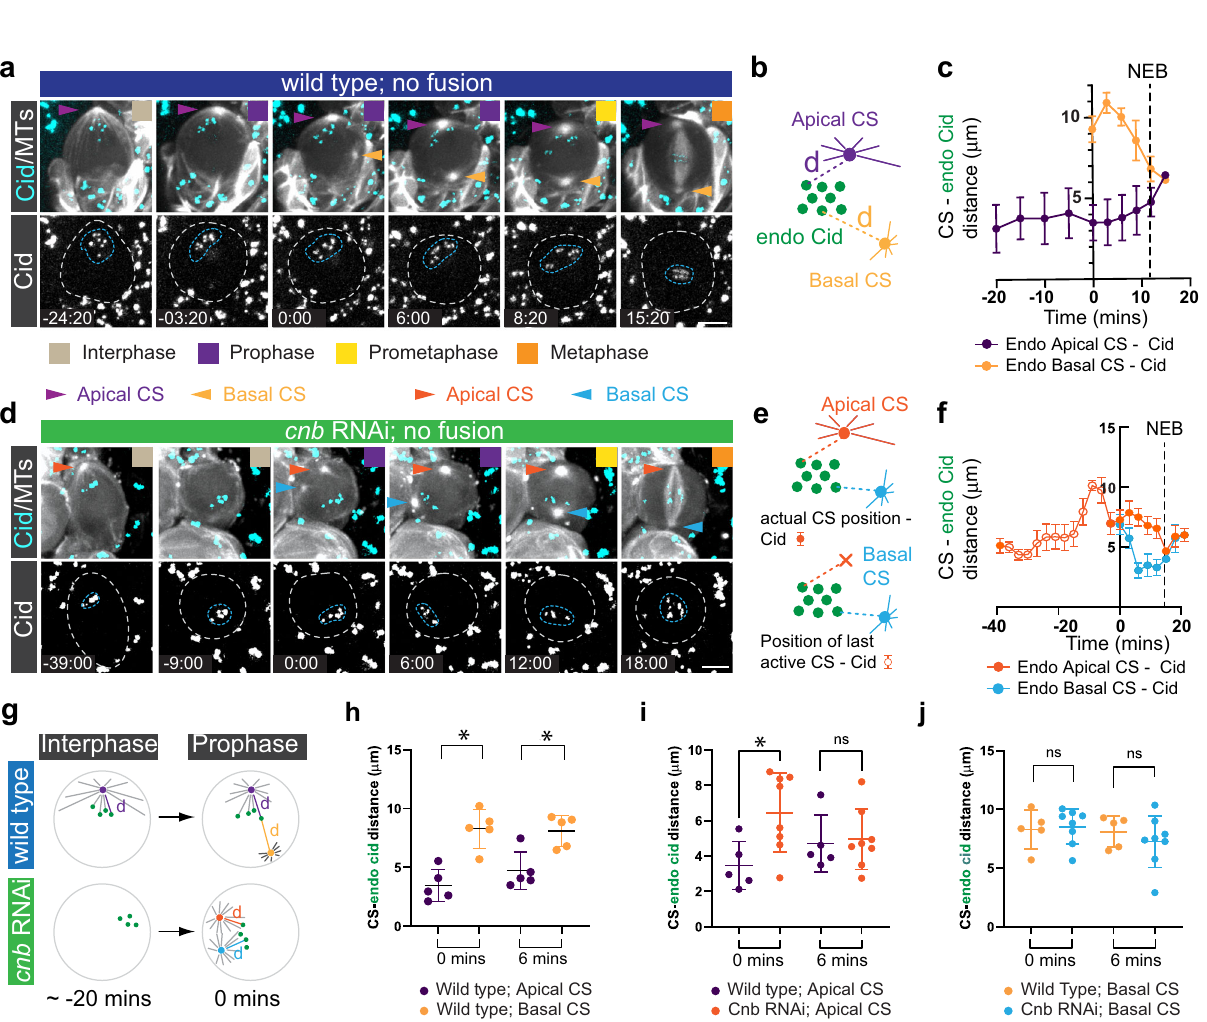
Fig. 3 asl mutant hybrid cells contain unfocused spindles. a Representative third instar larval control NB and b NB-GMC hybrid cell, expressing the centriole marker Asl::GFP (cyan) and the spindle marker cherry::Jupiter (MTOCs; white in top and bottom row). Neuroblast-derived and GMC-derived MTOCs were highlighted with green and red arrowheads, respectively. c Comparison of centrosome number between unfused wild type and hybrid cells. d The two NB-derived centrosomes (green) can either form a bipolar spindle (cis), or pair with ectopic, GMC-derived (red) centrosomes to form a bipolar spindle (trans). e , f Quanti fi cation of cis and trans spindles in wild type hybrid cells. g Unfused asl mutant neuroblasts and h asl mutant hybrid cells, expressing the chromatin marker His2A::GFP (cyan) together with the spindle marker cherry::Jupiter (white). Colored boxes represent corresponding cell cycle stages. Error bars correspond to SDs. Unpaired t-test was used in Fig. 3c. **** p < 0.0001. Time in mins:secs. Scale bar is 5 mm.